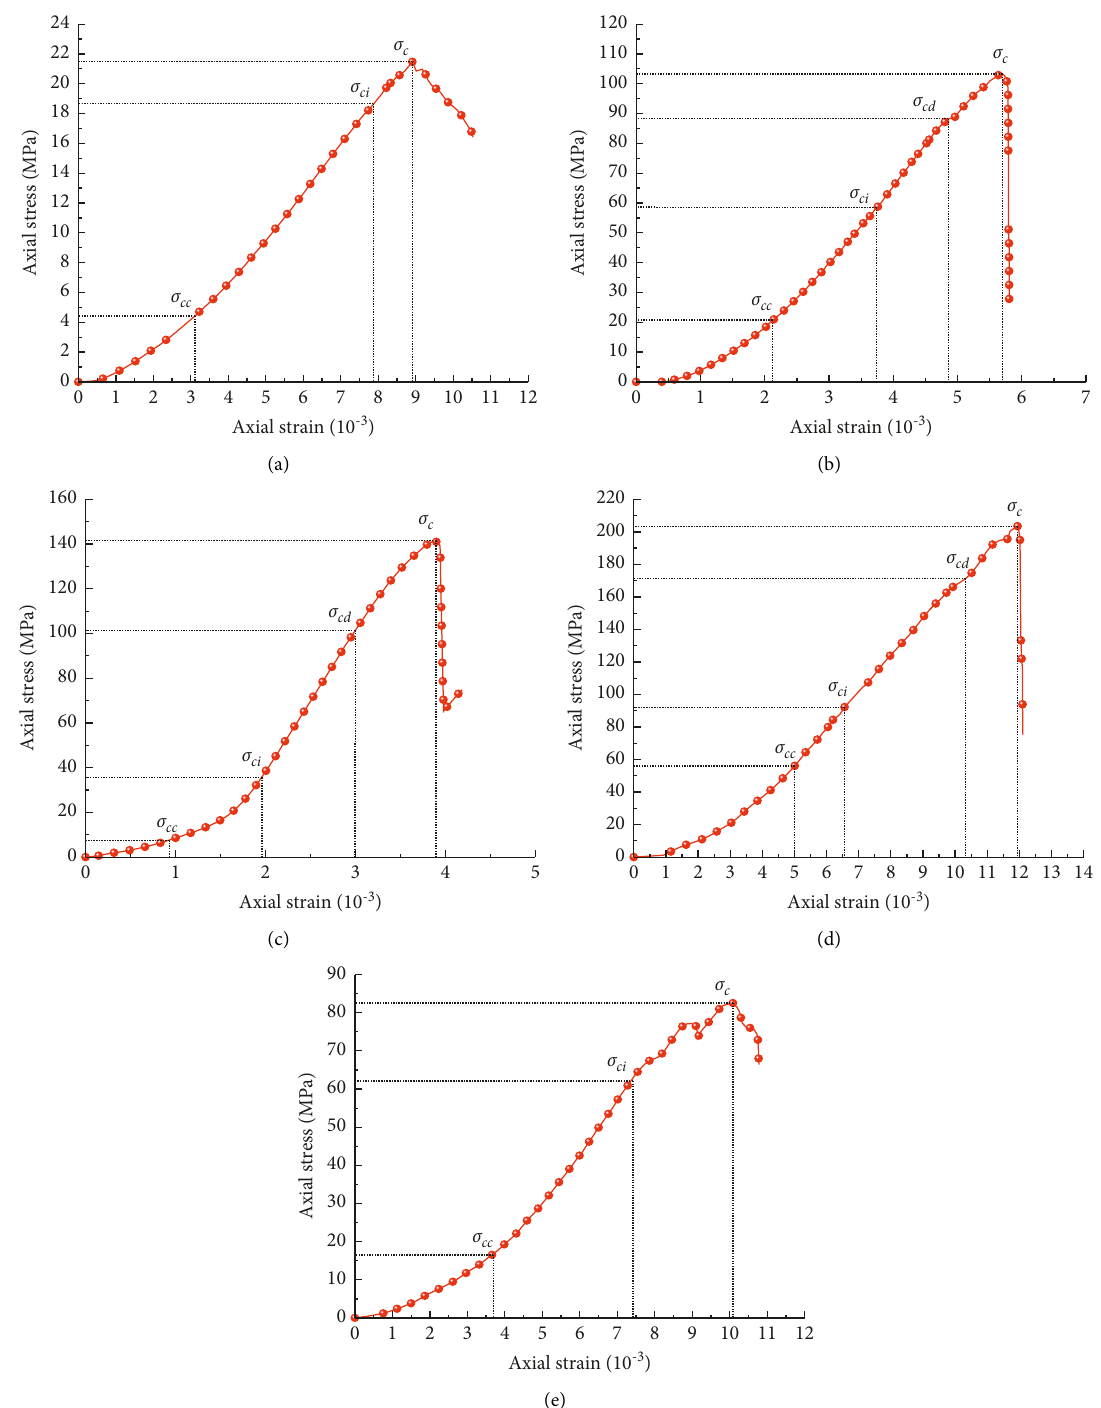
Figure 2: Uniaxial stress-strain curves in the different types of rocks. (a) Coal. (b) Granite. (c) Marble. (d) Shale. (e)